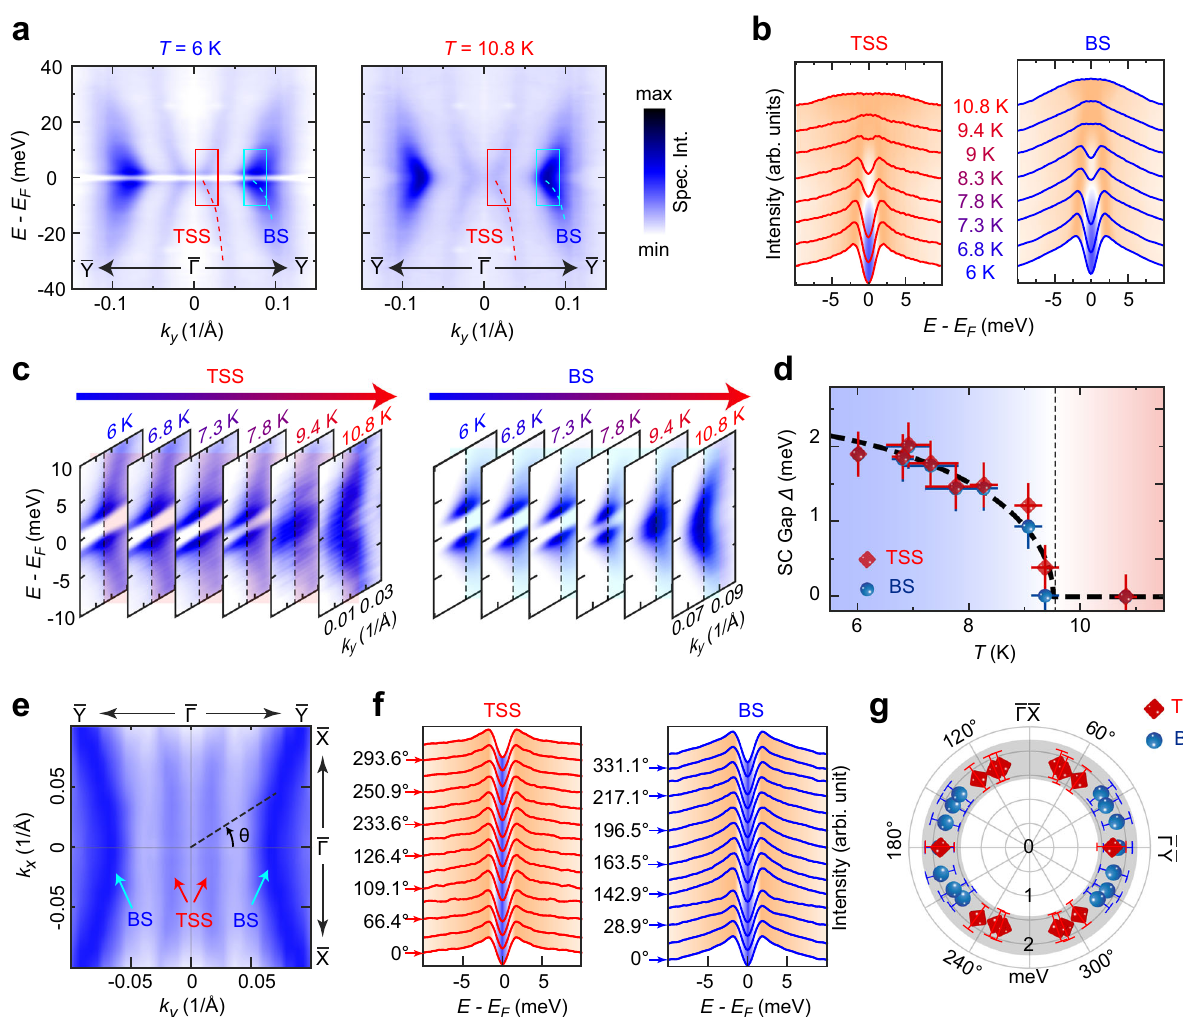
Fig. 4 Superconducting gap from the TSS and BS. a Photoemission spectra intensity plots of the band dispersions along (cid:1) Y (cid:1) (cid:1) Γ (cid:1) (cid:1) Y direction in the superconducting (left) and normal (right) states show clear superconducting gaps from both the TSS (red dashed lines) and BS (blue dashed lines, which show clear k z broadening and form the bulk α pocket in Supplementary Fig. 5). Note that to better illustrate the gap, the spectra are symmetrized in energy direction with respect to E F (same in plots b , c , f below). b Temperature dependence of the energy distribution curves (EDCs) at the Fermi momentum ( k F ) of TSS (left) and BS (right) shows the opening of the superconducting gap below T = 9 K. c Temperature dependence of the band dispersions of the TSS (left) and BS (right) across k F (the momentum and energy range plotted here corresponds to the red and cyan rectangle area marked in a , again shows the clear superconducting gap below T C . d Temperature evolution of the superconducting gap from the TSS and BS (details on the gap extraction from the AREPS spectra function can be found in Supplementary Fig. 7) is consistent with a mean fi eld temperature dependence, as indicated by the black dashed line. Horizontal error bars represent the temperature variance during the measurements. Vertical error bars represent the con fi dence intervals of the fi tting under 95% con fi dence level. e Constant energy contour plot (intensity integrated between E F to E b = 10 meV) shows the k F loci of the TSS and BS (T = 6 K). θ de fi ned the angle used in f , g . f EDCs from the k F loci of different θ angles at the superconducting state ( T = 6 K) show that the superconducting gap magnitude of both TSS (left) and BS (right) are nearly isotropic. g Plot of the superconducting gap size as a function of θ angle for both TSS (red symbols) and BS (blue symbols), showing similar magnitude. Error bars represent the energy resolution determined by ARPES spectra on multi-crystalline